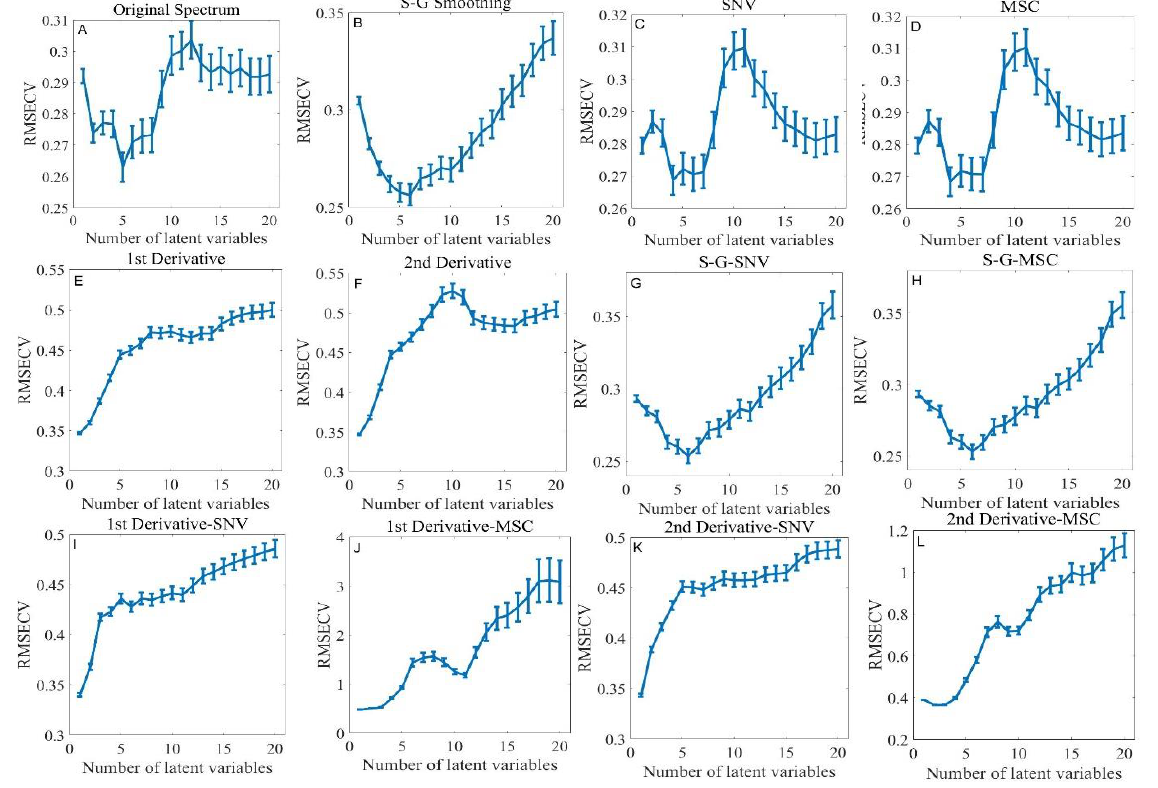
Figure 3. The results of 10-fold cross-validation. ( A ) Original spectra; ( B ) S-G smoothing spectra; ( C ) SNV; ( D ) MSC; ( E ) 1st derivative; ( F ) 2nd derivative; ( G ) S-G-SNV; ( H ) S-G-MSC; ( I ) 1st derivative-SNV; ( J ) 1st derivative-MSC; ( K ) 2nd derivative-SNV; ( L ) 2nd derivative-MSC.